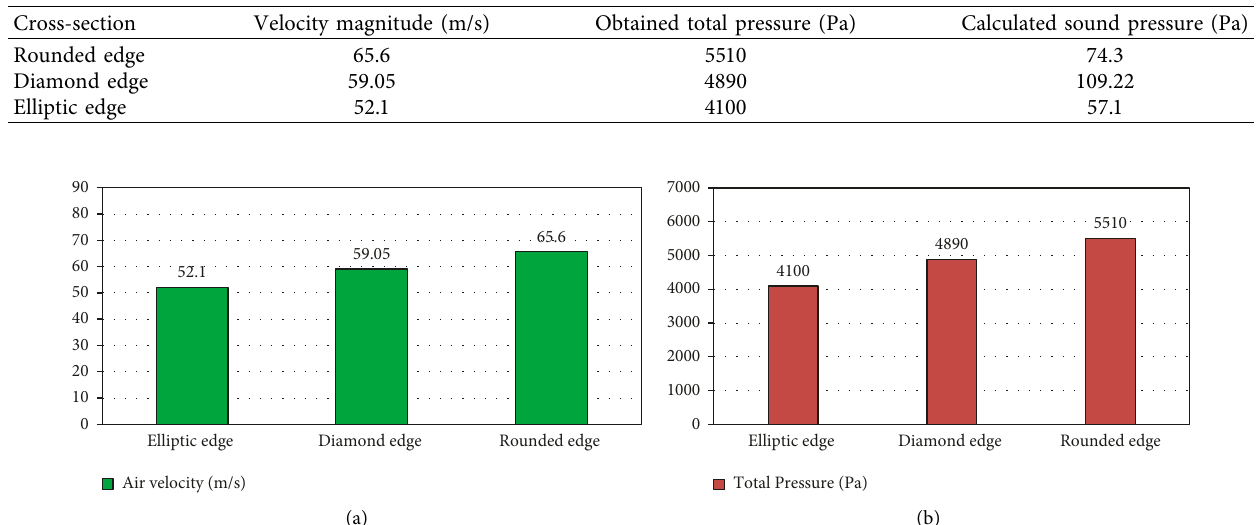
Figure 15: Comparison between the three different shapes of the pantograph panhead bars’ cross-section.